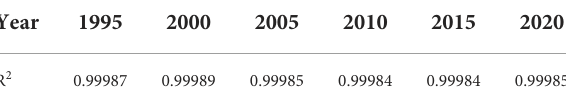
TABLE A2 Regression diagnostics for the rank-size estimations at the functional urban area